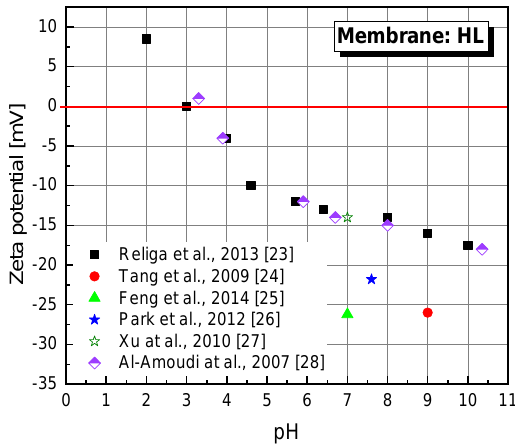
Figure 1. Dependence of zeta potential of the HL membrane on pH of the medium presented by different authors; [23] - Zeta potential of the membrane surface was determined by streaming potential, 1 mM KCl; [24] - Zeta potentials of the membrane were determined from streaming potential measurements in a background electrolyte of 10 mM NaCl; [25] - Zeta potential of the membrane was determined at pH 7.0 and 25 ◦ C in a 1 mM/L KCl solution, using streaming potential equipment; [26] - Zeta potential of the membrane was determined at pH 7.0 and 25 ◦ C in a 1 mM/L KCl solution, using streaming potential equipment; [27] - Zeta potential measured at pH 7 in 10 mM KCl solution.